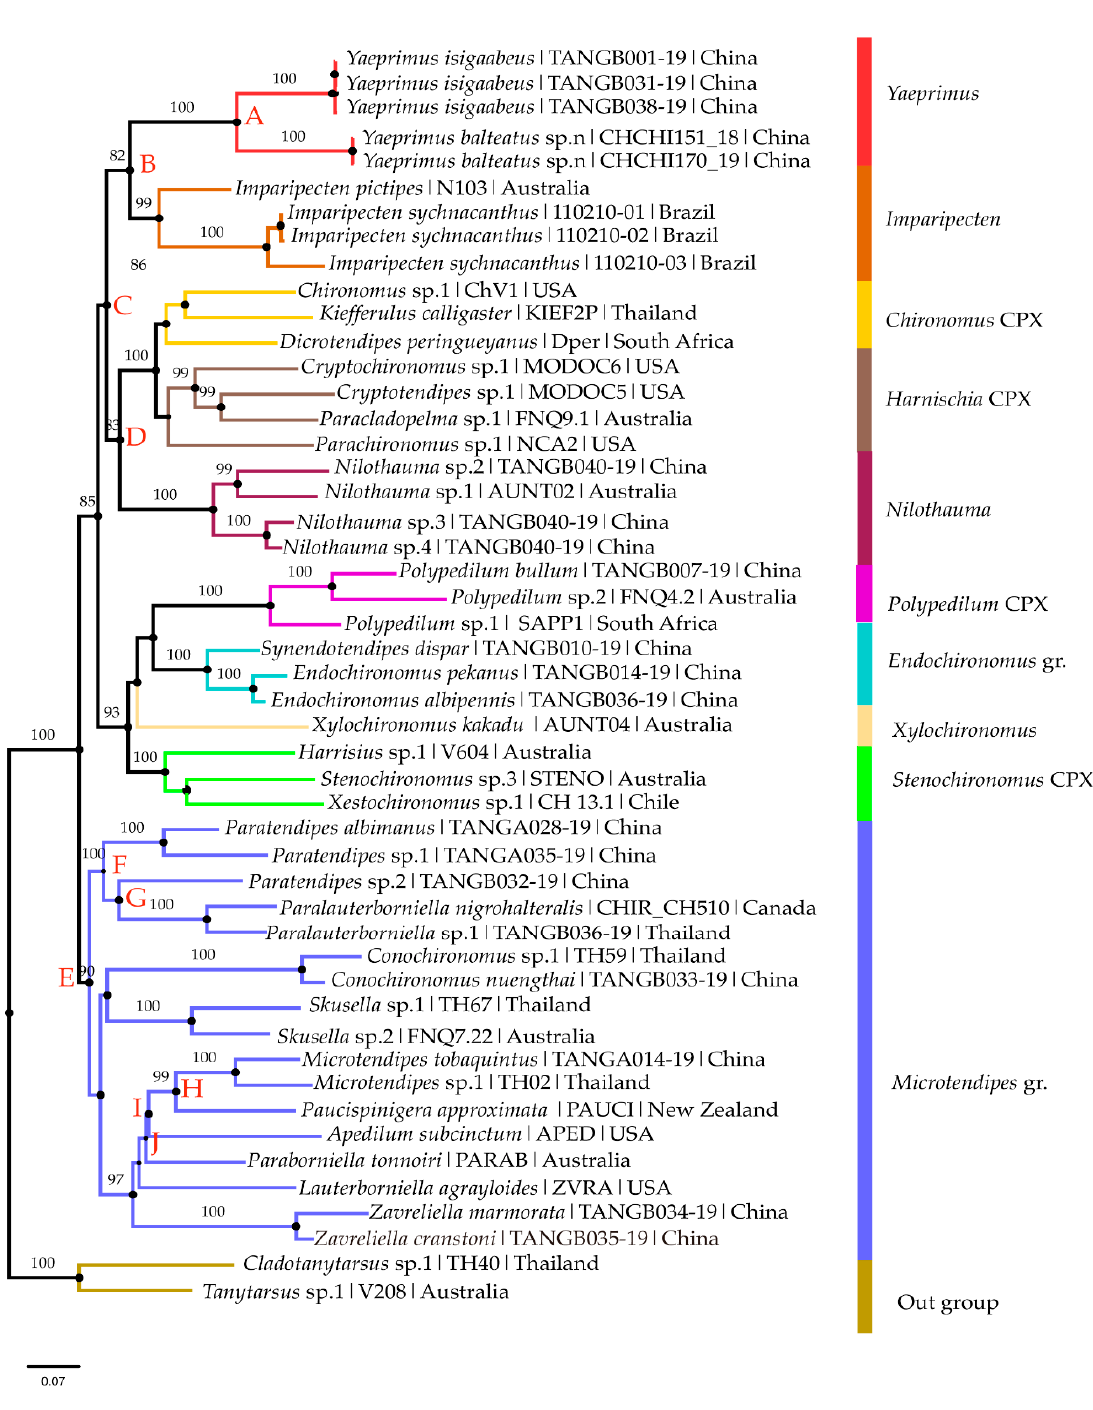
Figure 2. Maximum likelihood tree based on concatenated gene ( 18S , 28S CAD1 , CAD4 , COI–3P ) fragments. Nodes are labeled by bootstrap support (BS), only BS > 0.8 are shown.